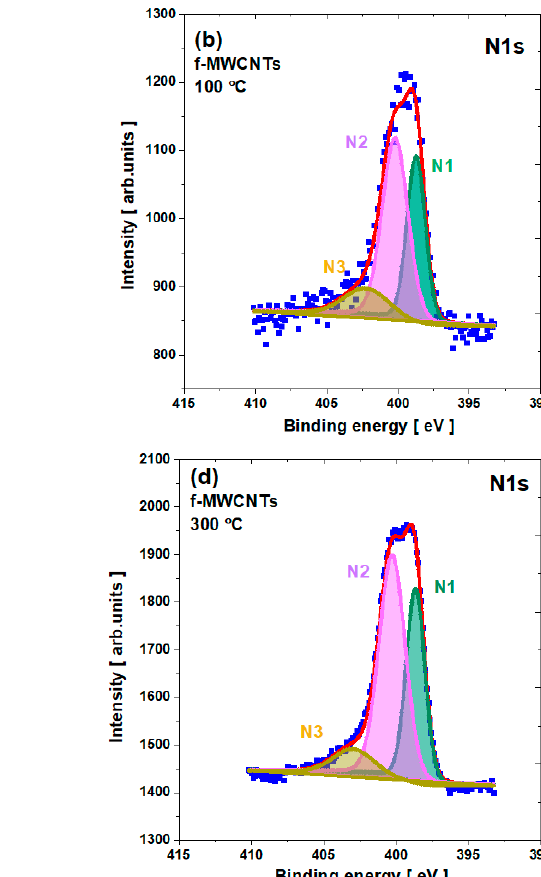
10 of 23 Figure 5. The C1s core level line for f-MWCNTs: ( a ) pristine; calcined at ( b ) 100 °C; ( c ) 200 °C; and ( d ) 300 °C. The N1s spectra of pristine and calcined nanotubes reveal several contributions re- lated to N-based functionalities (see Figure 6), namely N1, N2, N3, and N4 (see Table S2 in Supplementary Materials). The N1 peaking around 399 eV can be identified as pyridine and nitryl groups; N2 around 400 eV to amide, amine, lactam, and pyrrole; the N3 ob- served around 402 eV to quaternary nitrogen atoms bonded to three C atoms in the bulk of the graphene layers; the broad N4 peak around 406 eV to pyridine-N-oxide overlapped with probably dominated adsorbed N 2 [4,18,21,26]. The relative percentage of the different N-species was determined for each sample based on the deconvoluted spectra. For the pristine f-MWCNTs, we observe all four nitrogen-based lines, whereas, for the calcined specimens, only three components are visible with different relative percentage contribu- tions. Moreover, the N2 component dominates for both pristine and calcined nanotubes. This contribution is probably enhanced with Fe–N states due to the presence of Fe/Fe 3 C